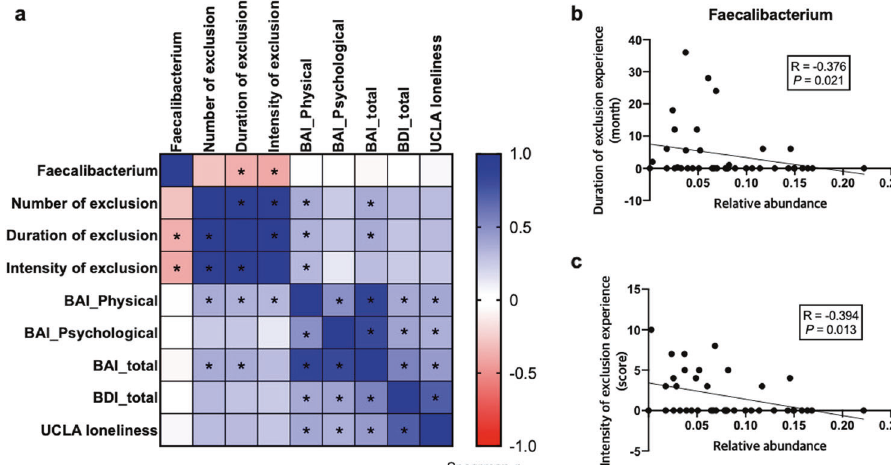
Fig. 2 Association between Faecalibacterium and psychological pain caused by social exclusion. a Heatmap of the correlation matrix between the relative abundance of Faecalibacterium and psychological indexes. Colors in the heatmap indicate Spearman ’ s correlation coef fi cient and asterisks indicate statistical signi fi cance ( p < 0.05). b , c Signi fi cant negative correlation of Faecalibacterium relative abundance with the duration ( b ) and intensity ( c ) of the exclusion experience; Spearman ’ s correlation coef fi cient (R) and the level of statistical signi fi cance ( p ) are indicated. Each dot represents the results for an individual